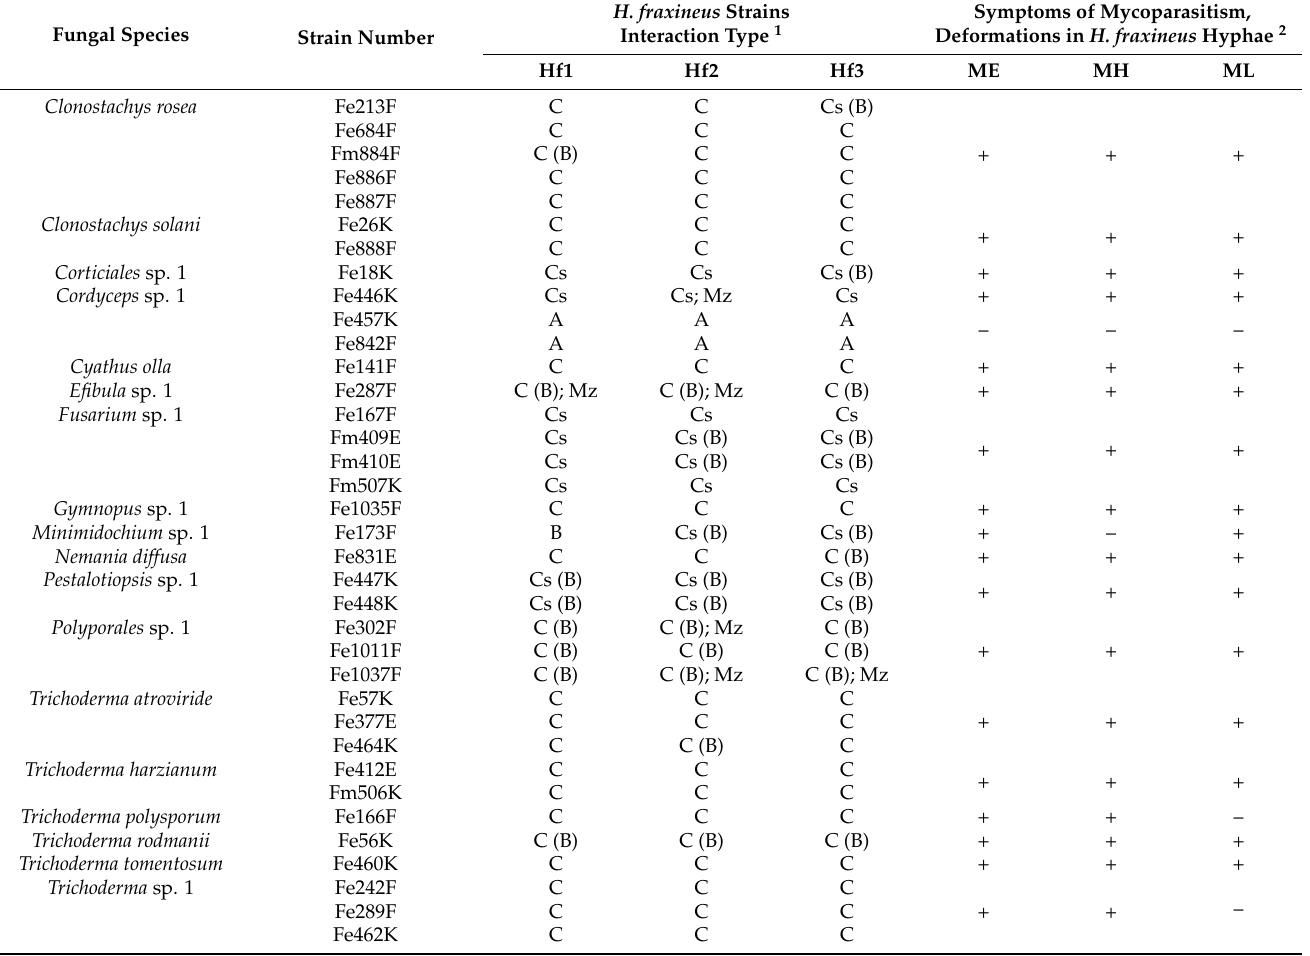
Table 2. Types of interactions of Hymenoscyphus fraxineus with test fungi in dual cultures in vitro and morphophysiological deformations in the hyphae of H. fraxineus